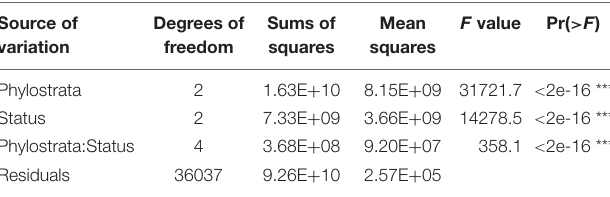
TABLE 1 | Two-way ANOVA test for comparison of the number of RNA-Seq samples with expression in different transcripts phylostrata and status. Source of Degrees of variation freedom